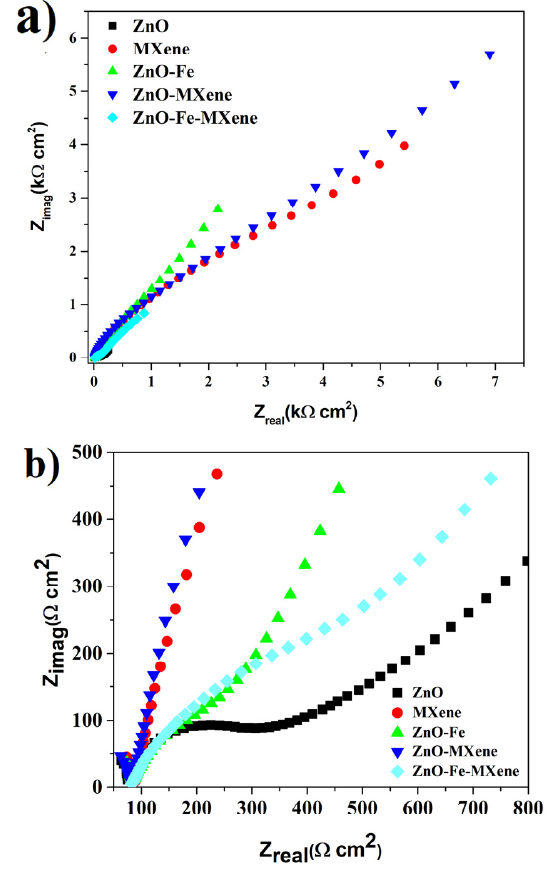
Figure 5. ( a ) Electrochemical impedance spectroscopy (EIS) studies of the various electrodes in the presence of CO 2 measured in 0.5 M NaOH under an applied potential of 0.2 V at room temperature; ( b ) Magnified high-frequency region of the prepared composites.